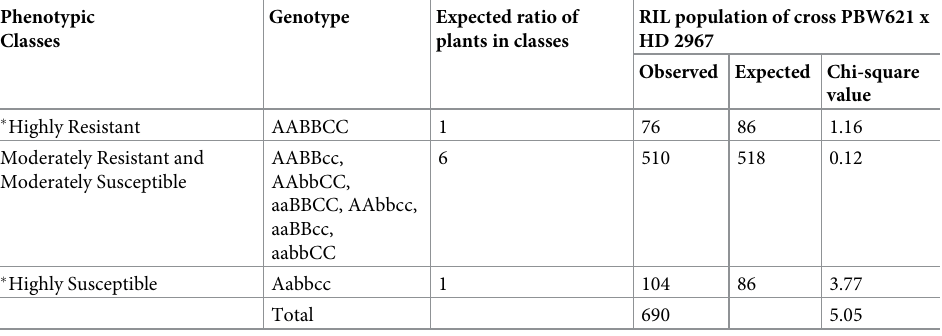
Table 5. Segregation of F 8 RIL population of cross PBW 621 X HD 2967 against stripe rust mixture